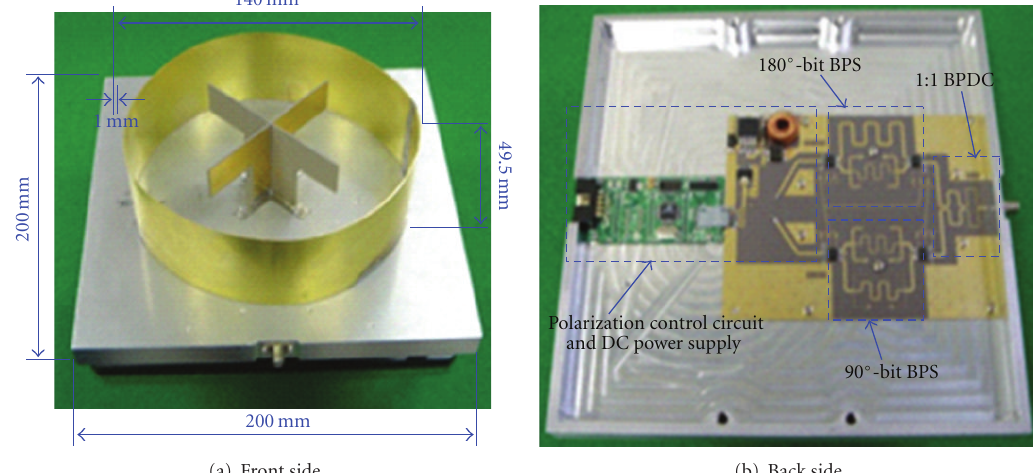
Figure 9: Photos of the fabricated BPCDE PR prototype.